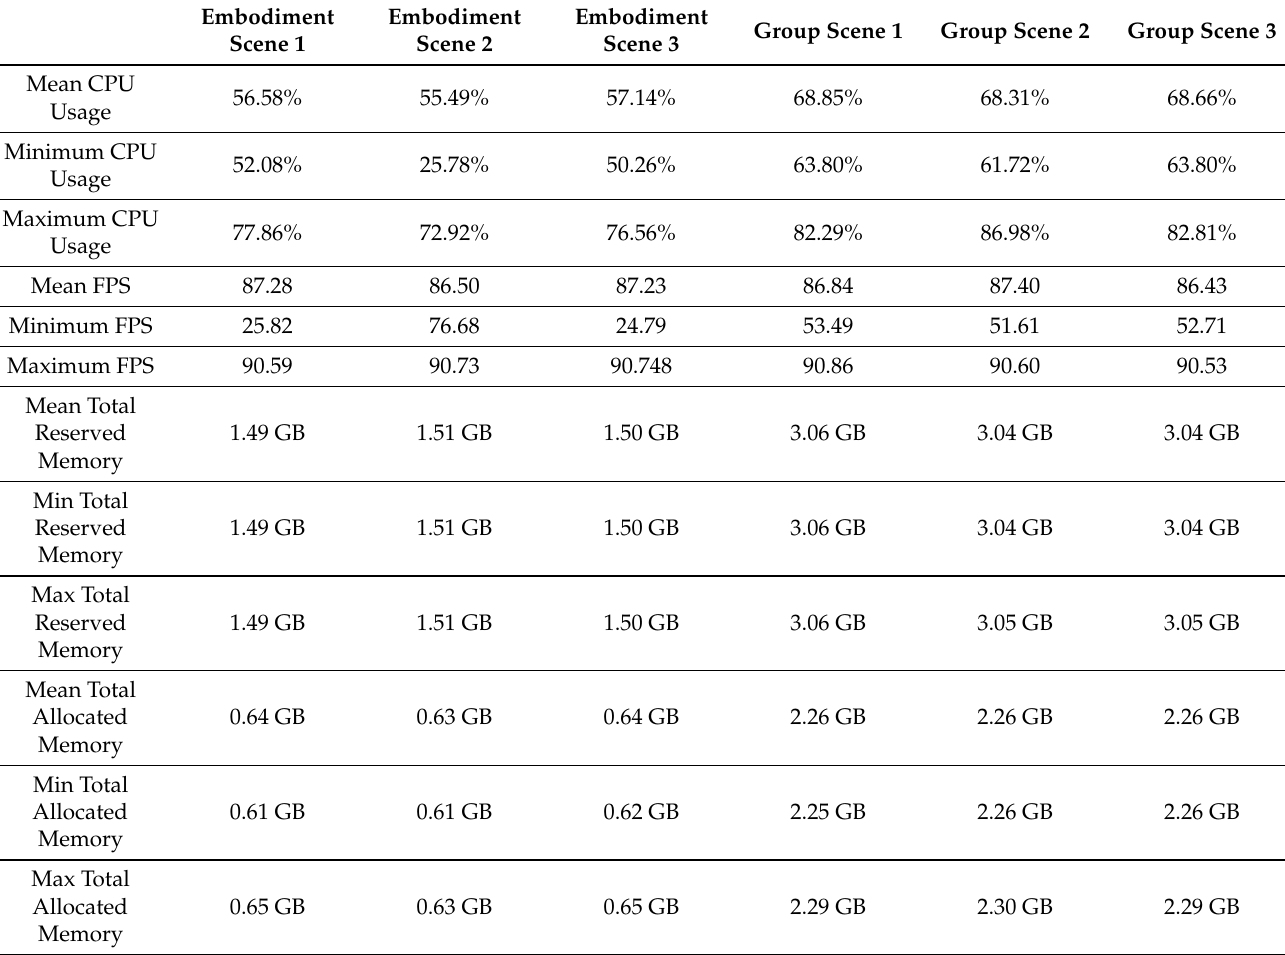
Table A7. Results for Test Condition 4: EEG Sensor.